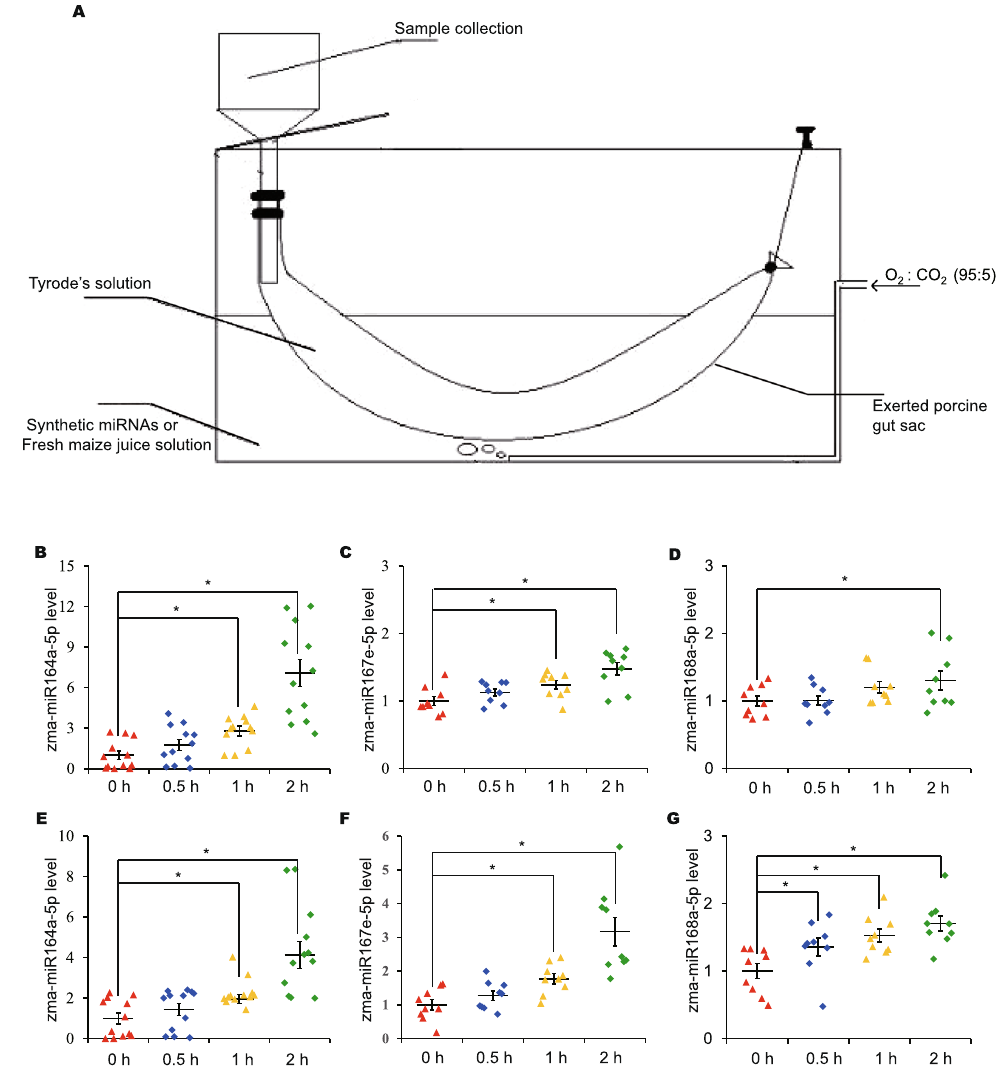
Figure 3. Assessing the absorption of exogenous miRNA in the intestine using an ex vivo everted gut sac. ( A ) The everted gut sac method was used to evaluate the absorption of plant miRNAs in the small intestine. An everted porcine gut sac was ligated and placed in synthetic miRNA or fresh maize juice solution, the medium was gassed by bubbling at 37 °C with 95% O 2 and 5% CO 2 , and the liquid in the internal capsule was collected at different times. ( B–G ) The levels of plant miRNAs in the collected fluid of the internal capsule after the gut sac had been placed in fresh maize juice ( B–D ) or synthetic miRNA ( E–G ) solution. After 0, 0.5, 1 and 2 h, zma- miR164a-5p ( B, E ) ( n = 12), zma-miR167e-5p ( C , F ) ( n = 9) and zma-miR168a-5p ( D, G ) ( n = 9) levels were evaluated by qRT-PCR. Statistical significance was determined by Student’s t -test ( * P <